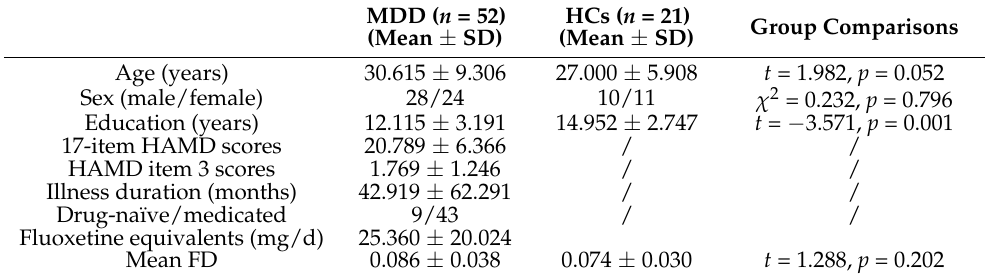
Table 1. Demographic, clinical, and head motion characteristics of the groups. SD, standard devi- ation; MDD, major depressive disorder; HCs, healthy controls; HAMD, Hamilton Rating Scale for Depression; FD, framewise-displacement.